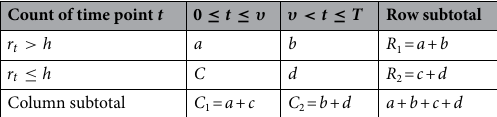
Table 1. Contingency table of Fisher’s Exact